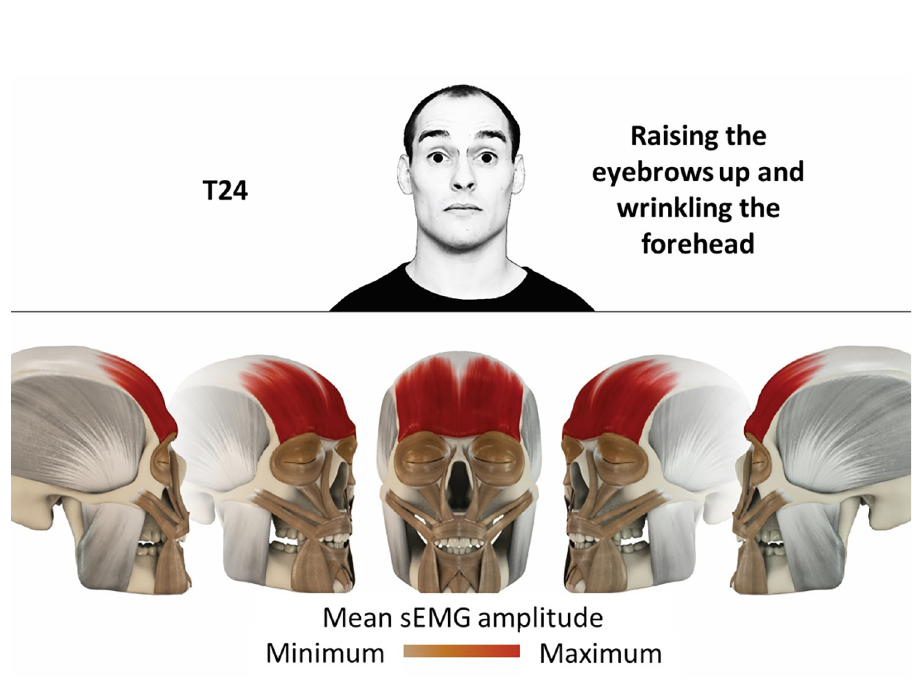
Fig 25. Color-coded facial muscle activation pattern of task T24. Raising eyebrows up and wrinkling the forehead. Animation by Jonas Laustro¨er.